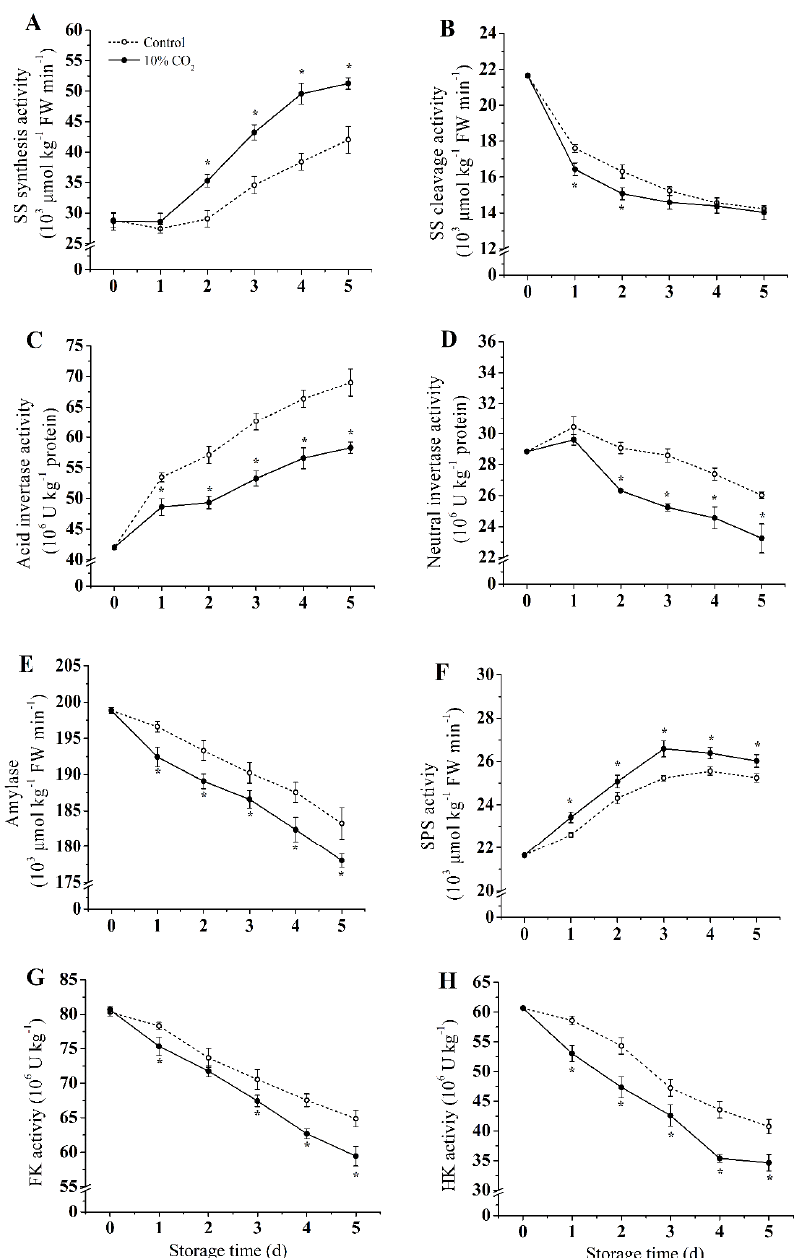
Figure 3. Effect of CO 2 on activities of sucrose synthase (SS)-synthesis ( A ), SS-cleavage ( B ),